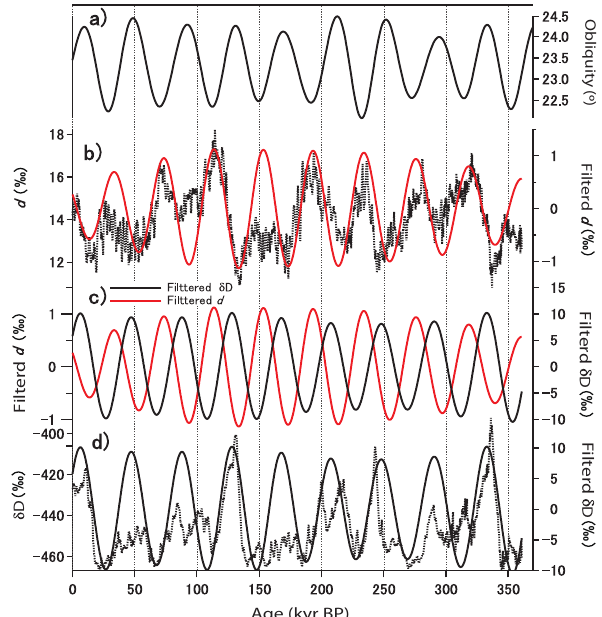
Fig. 8. Obliquity components of the DF isotope records. (a) Earth’s obliquity, (b) the raw d record of DF (black dotted line) and its fil- tered signal (red solid line). The filtered obliquity component was obtained by Gaussian filters with the Analyseries program (Pail- lard et al., 1996). A band-pass filter in the obliquity band ( f = 0 . 025±0.005) was calculated (red solid line). (c) Filtered compo- nents in the DF d (red solid line) and δ D (black solid line), (d) the δ D (black dotted line) record of DF and its filtered signal (black solid